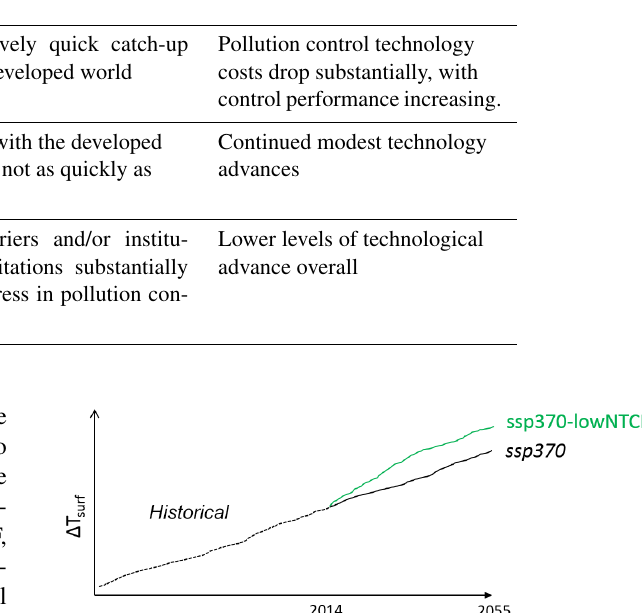
Table 3. Qualitative framework for pollution control in the SSPs, based on Rao et al. (2017) Table 2. Policy strength